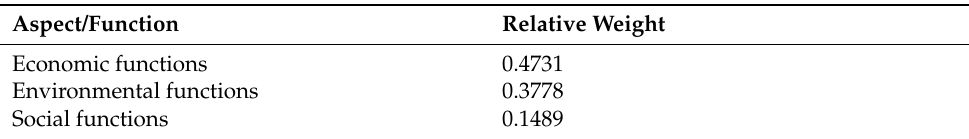
Table 8. Results of the AHP on weighting the relative importance of three dimensions of bioenergy projects.